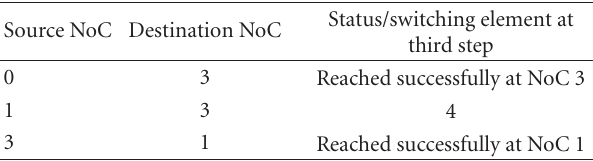
Table 5: Intermediate SE information while data moves from source NoC to destination NoC at fourth step of best